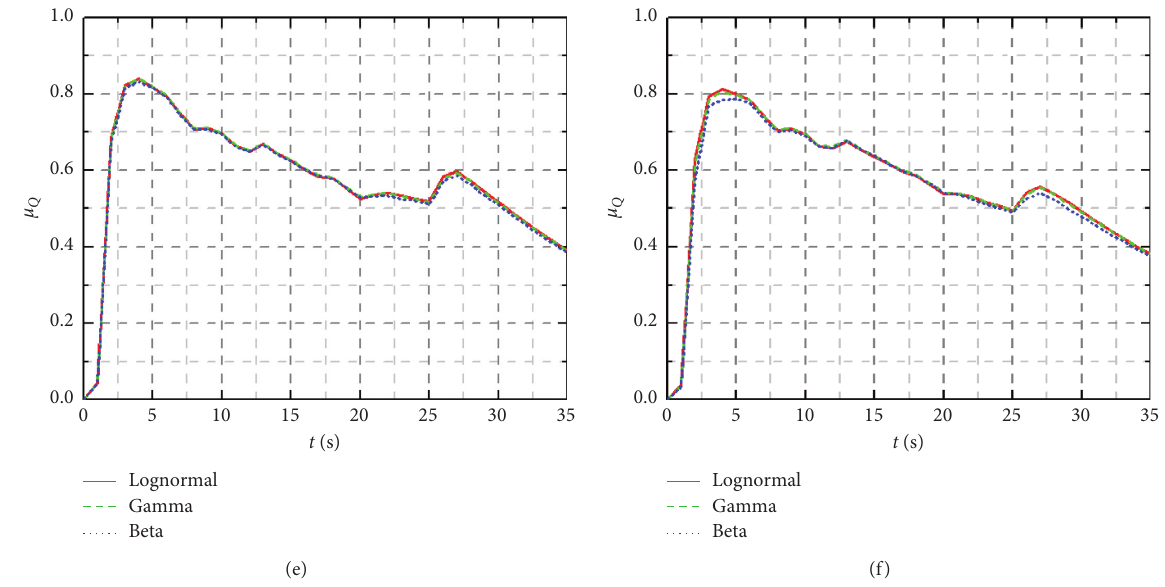
Figure 3: Time history curves of μ